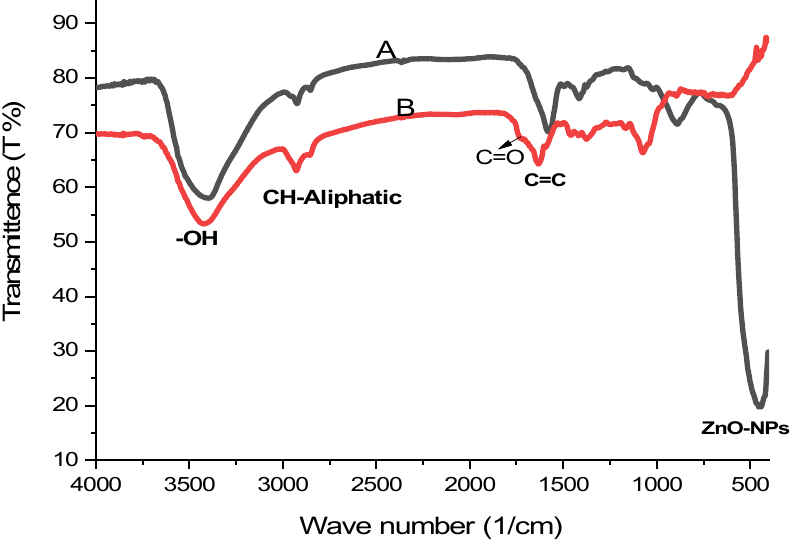
Figure 5. FT-IR spectrum of alcoholic extract of the C. diurnum leaf parts (ethanolic extract) ( A ), and FT-IR spectrum of ZnO-NPs ( B ).